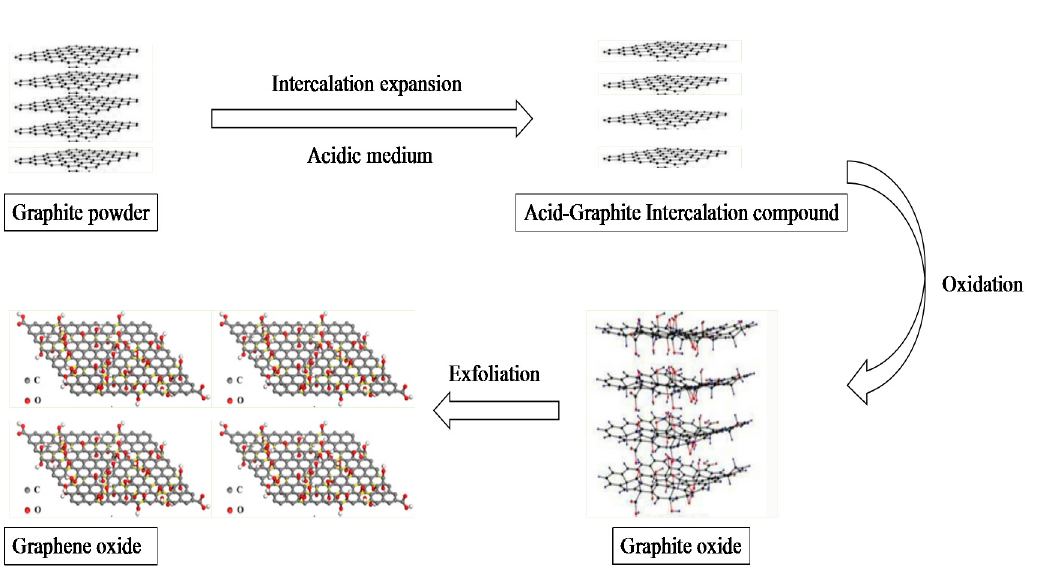
Figure 3. Schematic illustration of GO preparation process.